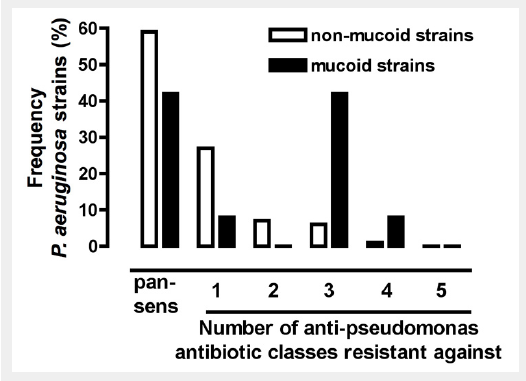
Frequency of resistances against 5 anti-pseudomonas antibiotic classes in 112 COPD patients, all colonised with non-mucoid (n = 112) and some additionally with mucoid (n = 12) P. aeruginosa strains . The anti-pseudomonas antibiotic classes tested are detailed in the Methods section and in table 1. Pan-sens, pan- sensitive P. aeruginosa isolates.